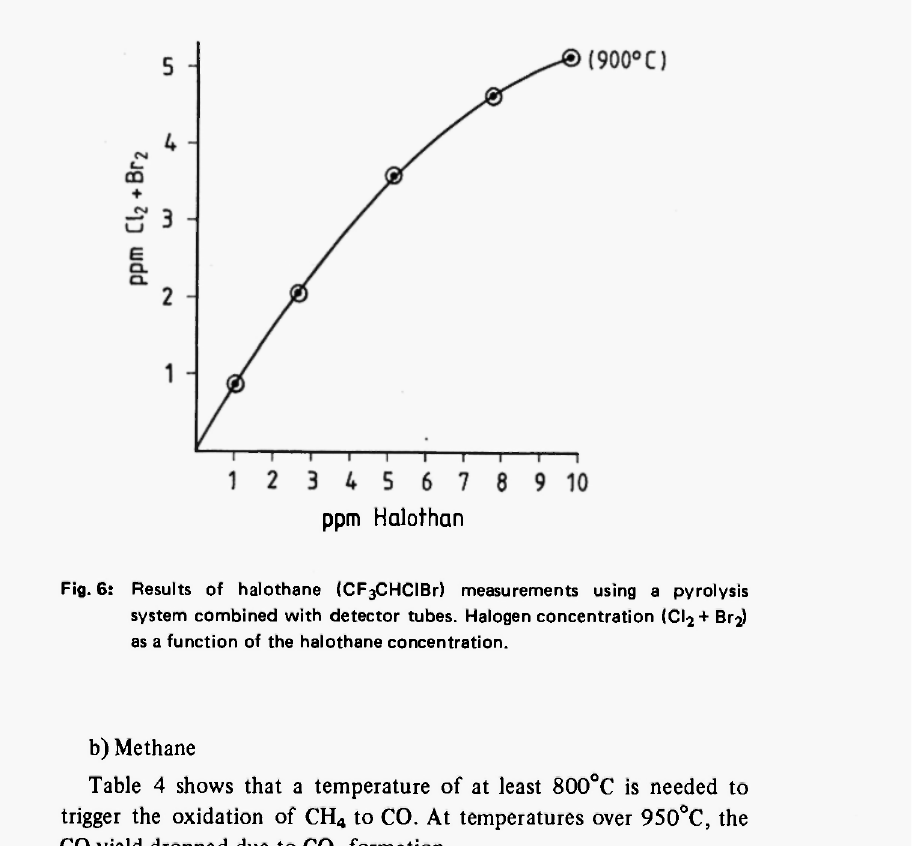
Fig. 6: Results of halothane (CF 3 CHCIBr) measurements using a pyrolysis system combined with detector tubes. Halogen concentration (Cl 2 + Br 2 ) as a function of the halothane concentration.